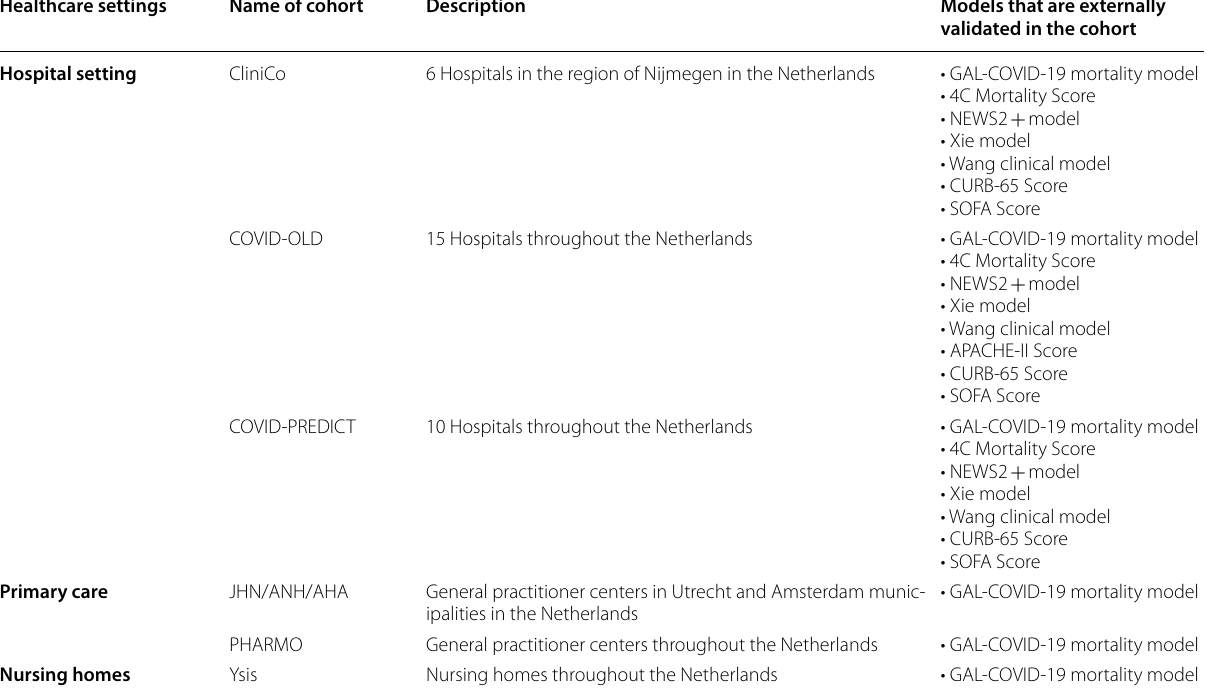
Table 2 Details of study cohorts Healthcare